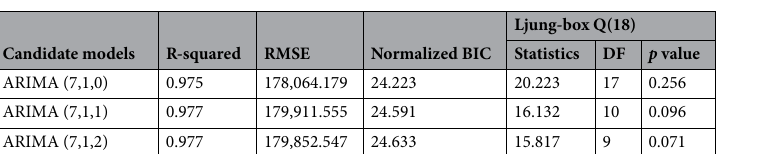
Table 2. Parameter estimation of the candidate ARIMA